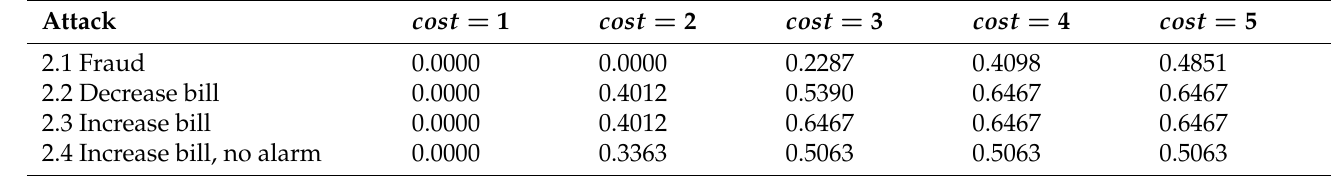
Table 13. Smart home and smart meter hijacking use case risk exposure